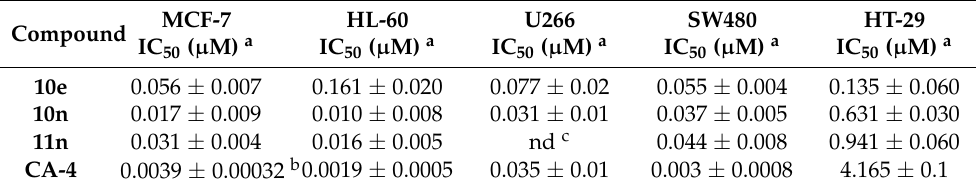
Table 5. Antiproliferative effects of selected β -lactam compounds 10e , 10n and 11n in MCF-7 human breast, HL-60 leukaemia, U266 multiple myeloma, SW480 and HT-29 colon cancer cell lines. MCF-7 Compound IC 50 ( µ M) a